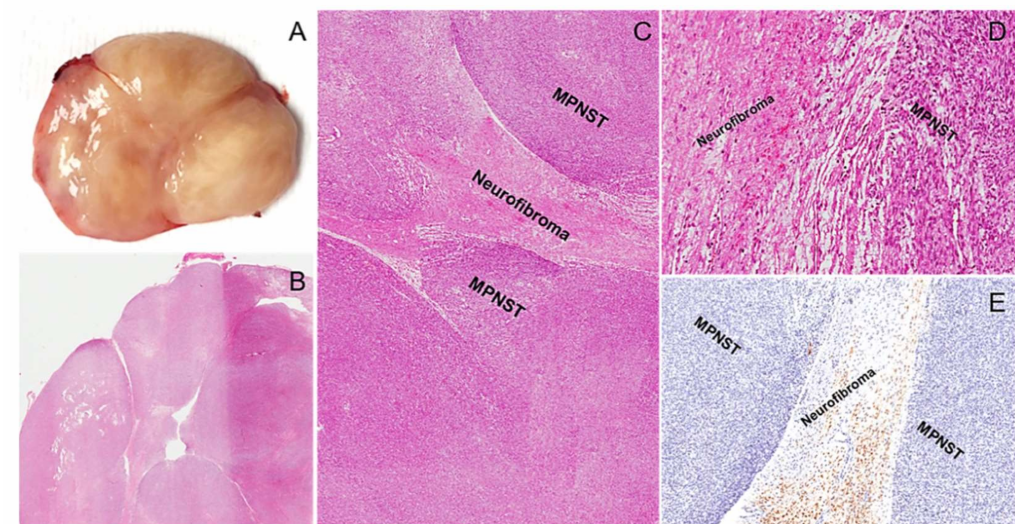
Figure 21. Classic malignant peripheral nerve sheath tumor (MPNST) arising in a neurofibroma. ( A ) Grossly, the tumor exhibits a multinodular, yellow to whitish in color, appearance. ( B ) Low-magnification image showing a hypercellular spindle cell tumor with a multinodular architecture. ( C ) Areas of low-grade MPNST are intermingled with a residual neurofibroma component. ( D ) Abrupt transition of residual neurofibroma into low-grade MPNST is seen. ( E ) Unlike MPNST, neurofibroma cells are strongly and diffusely stained with S100 protein.